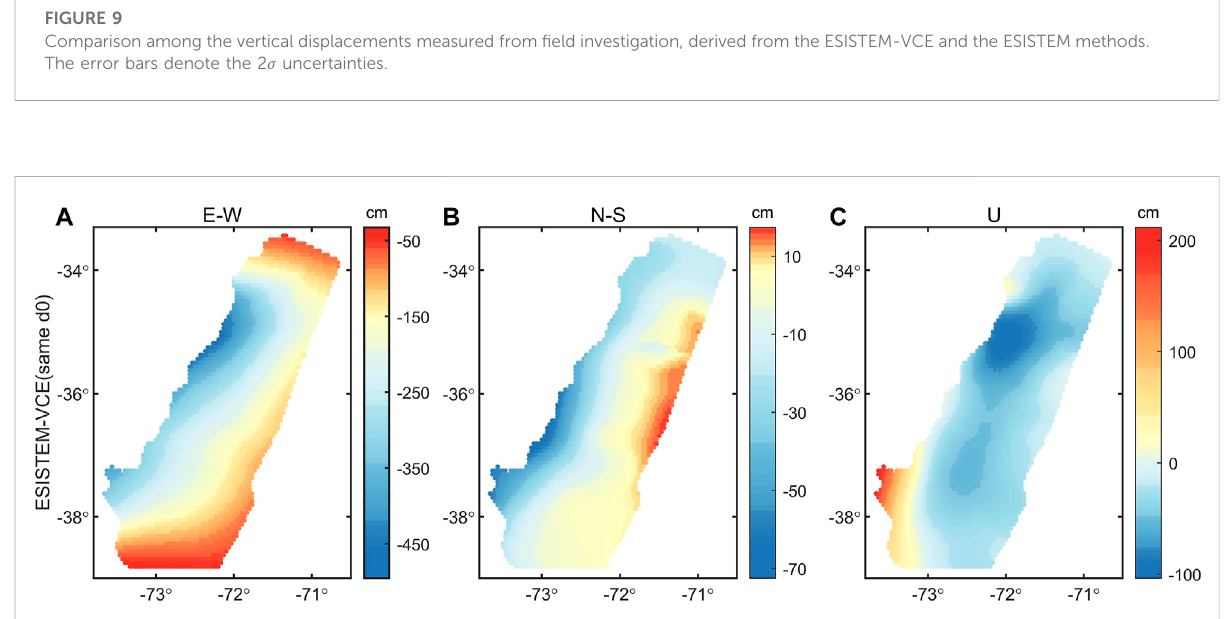
Three-dimensionalsurfacedisplacement fi eldderivedfromtheESISTEM-VCEmethodwiththesamedistance – decayingconstantsforGPSand InSAR data. (A) The east-west displacement. (B) The north-south displacement. (C) The vertical